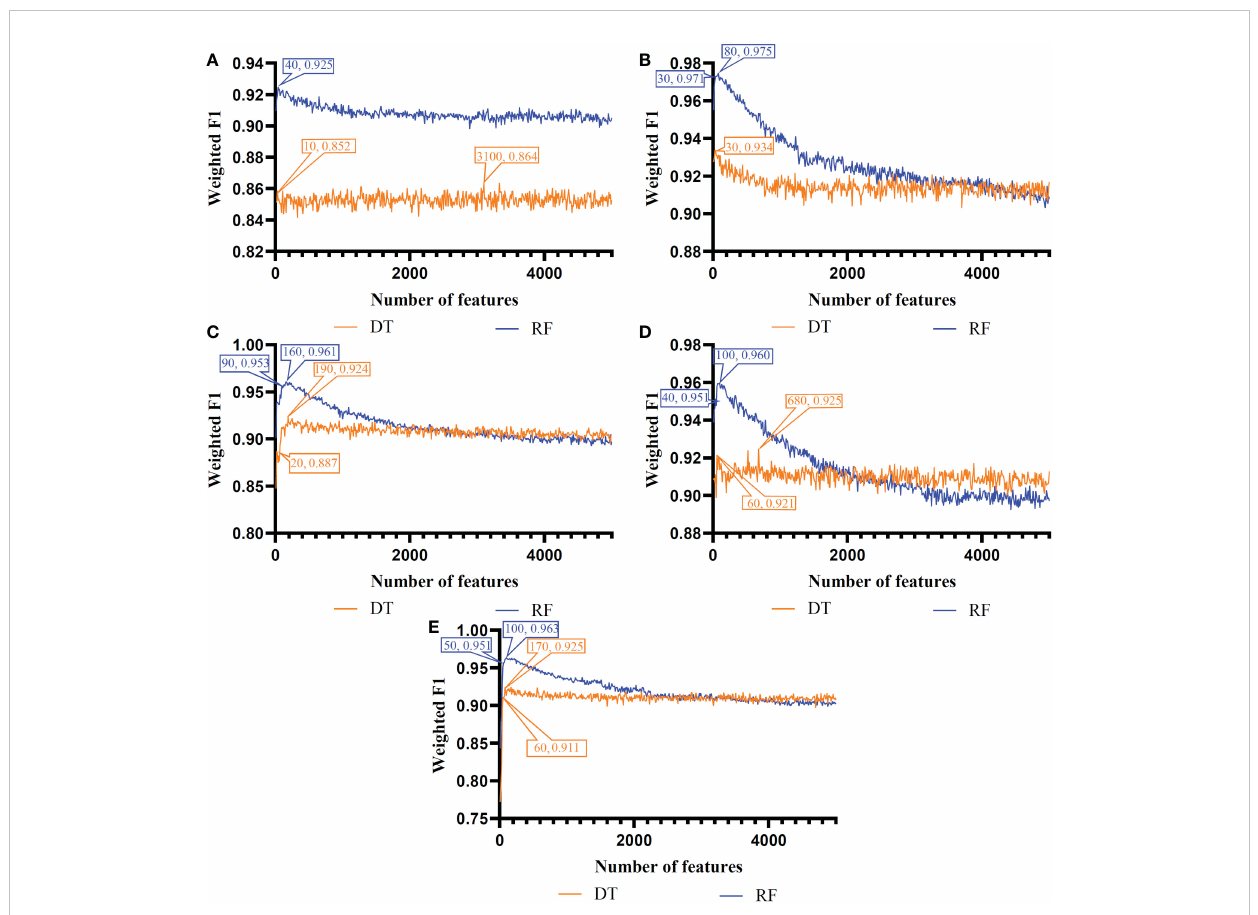
FIGURE 3 Incremental feature selection (IFS) curves of two classi fi cation algorithms in CD8 + T cells. (A) IFS results obtained based on the LASSO gene list. (B) IFS results obtained based on the LightGBM gene list. (C) IFS results obtained based on the mRMR gene list. (D) IFS results obtained based on the MCFS gene list. (E) IFS results obtained based on the PFI gene